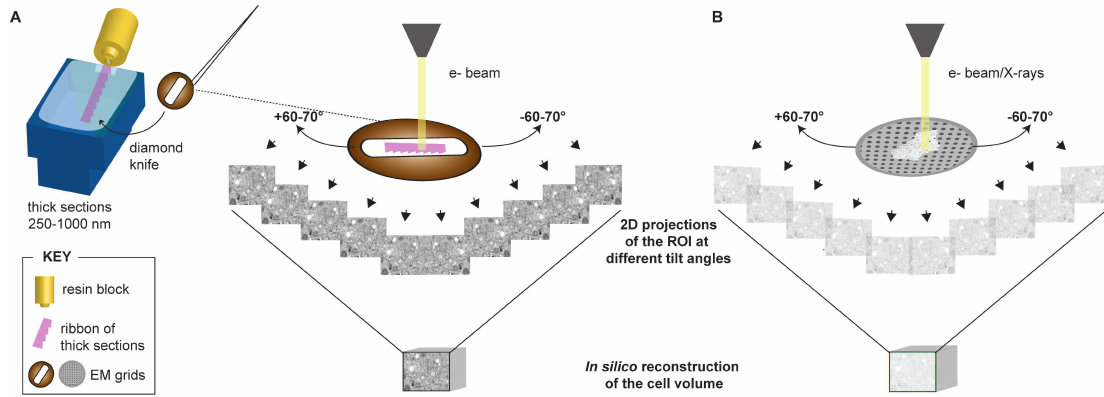
Figure 5. Principle of electron tomography (ET) and 3D reconstruction. ( A ) Thicker sections (250–1000 nm, in pink) of virus-infected cells can be analyzed by means of electron tomography (ET) or scanning transmission electron microscopy (STEM) tomography using microscopes operated with voltages >100 kV. The sections are tilted relative to the incident electron beam in an automatic fashion with help of a goniometer. 2D projections of the same field of view are acquired every tilted angle, from which the cell volume is subsequently reconstructed in silico ; ( B ) Following the same working principle, cryo-ET, cryo-STEM tomography or soft X-ray cryo-tomography can be applied to vitrified cells grown on EM grids. For this purpose, the microscope must be operated at very low temperatures and with low electron doses (in the case of cryo-ET and cryo-STEM tomography). Alternatively thick cryo-sections collected on an EM grid as in ( A ) can be analyzed by CETOVIS (see text for further details). The diagrams of the ET-working principle are adapted from Baumeister et al.